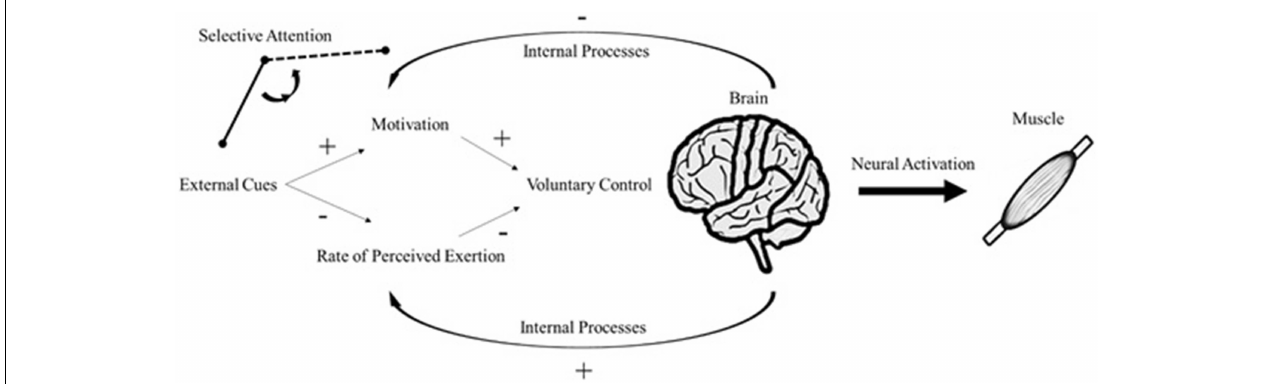
FIGURE 1 | An update on the psychobiological model of endurance performance. Plus signs represent a positive effect on the subsequent response; conversely, minus signs represent a negative effect on the subsequent response (e.g., internal processes decrease motivation and increase RPE).